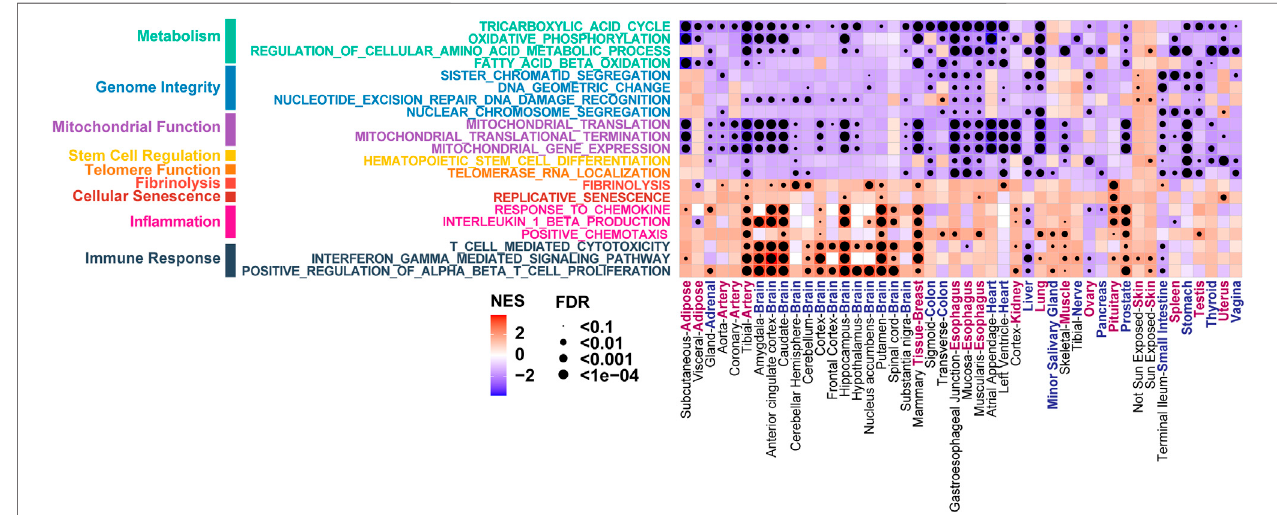
FIGURE 2 | Aging-associated gene expression in the GTEx can recapitulate the well-established aging hallmarks. The Normalized Enrichment Score (NES) and False Discovery Rate (FDR) of GSEA analysis are shown for gene sets grouped by different aging hallmarks in each tissue type.